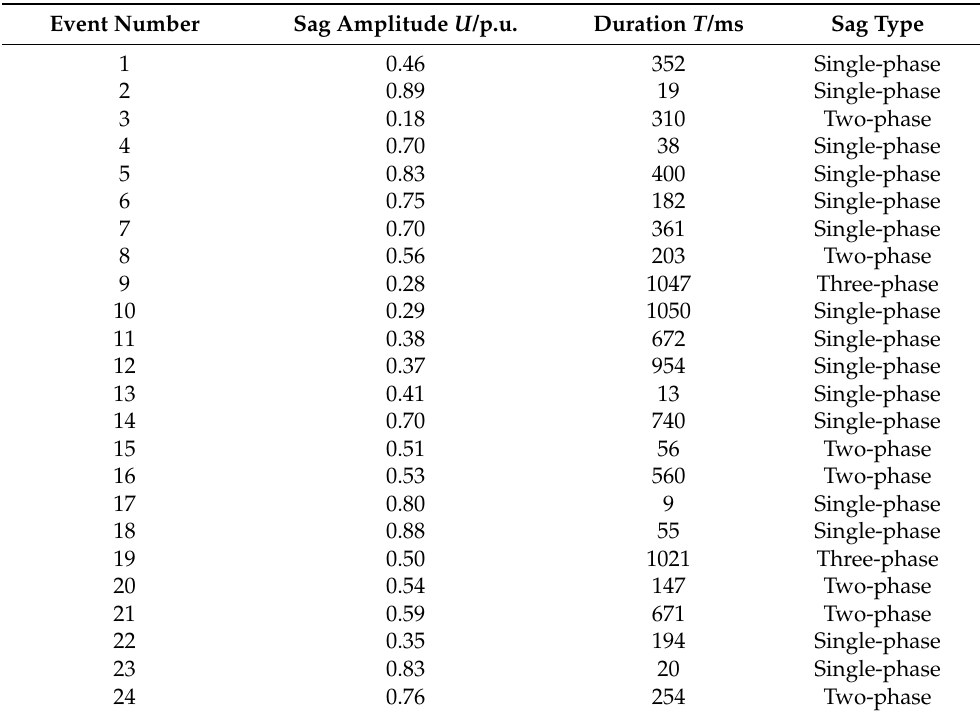
Table 3. Sag feature information for sag event.